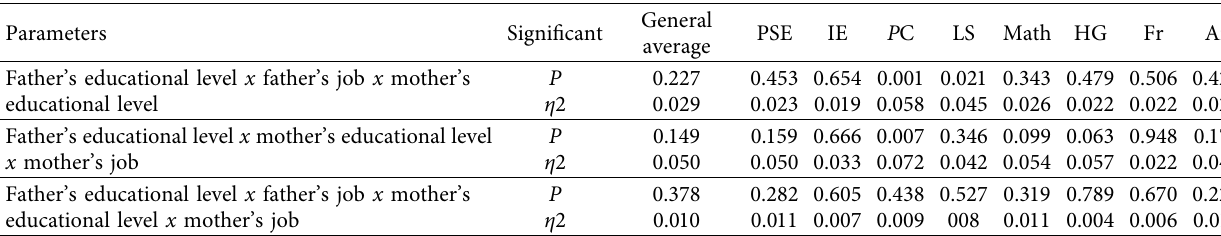
Table 7: Effect of parents’ job x their educational level on student’s academic outcomes (suite).